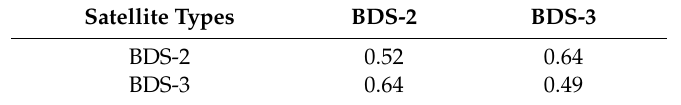
Table 3. Correlation coefficients (average) between different satellites over one day (DOY 60, 2019).